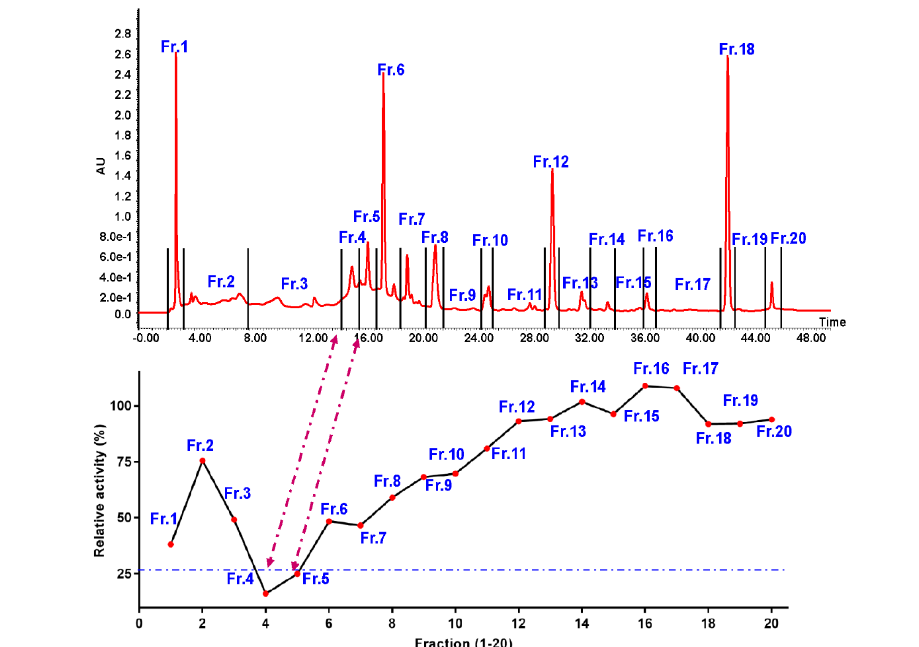
FIGURE 2 - (a) HPLC-UV fingerprint of P. cuspidatum ethanol extract (50 mg/mL) monitored at 270 nm, Fr.1-Fr.20 represent eluted fraction numbered from 1 to 20, and (b) the corresponding EcGUS inhibition profile of each eluted fraction (2 μg/mL) towards EcGUS-mediated DDAOG hydrolysis. Note: trans-resveratrol 4’-O-β-D-glucopyranoside ( HZ-1 ) and (-)-Epicatechin gallate ( HZ-2 ) were purified from Fr. 4 and Fr. 5, respectively.